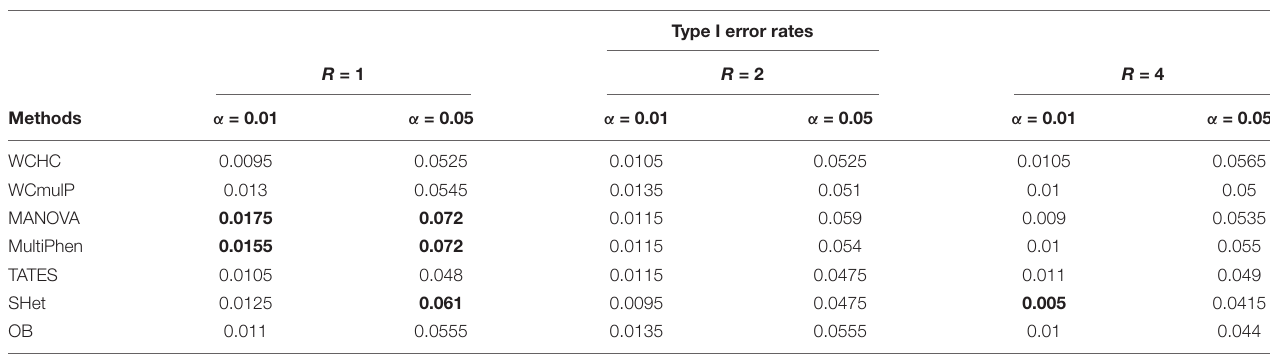
TABLE 2 | Type I error rates of the seven methods in three simulation